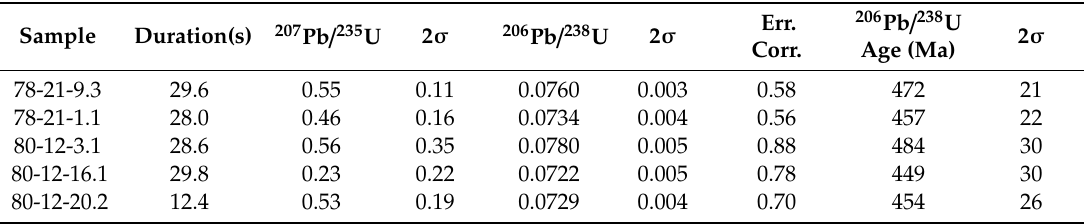
Table 2. U-Pb titanite geochronological data from oldest population in the lamprophyre dyke (samples 78-21 and 80-12).